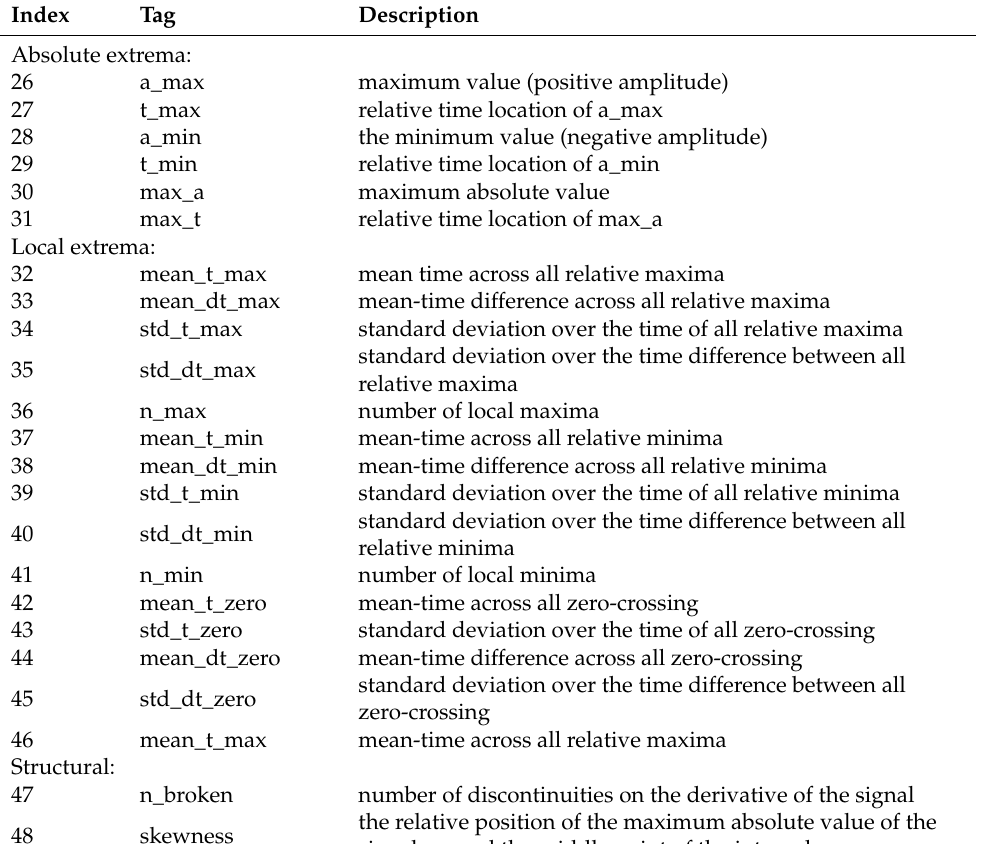
Table 3. Features extracted only from S1 and S2 intervals of the heartbeat cycle (tagged as S1 and S2,